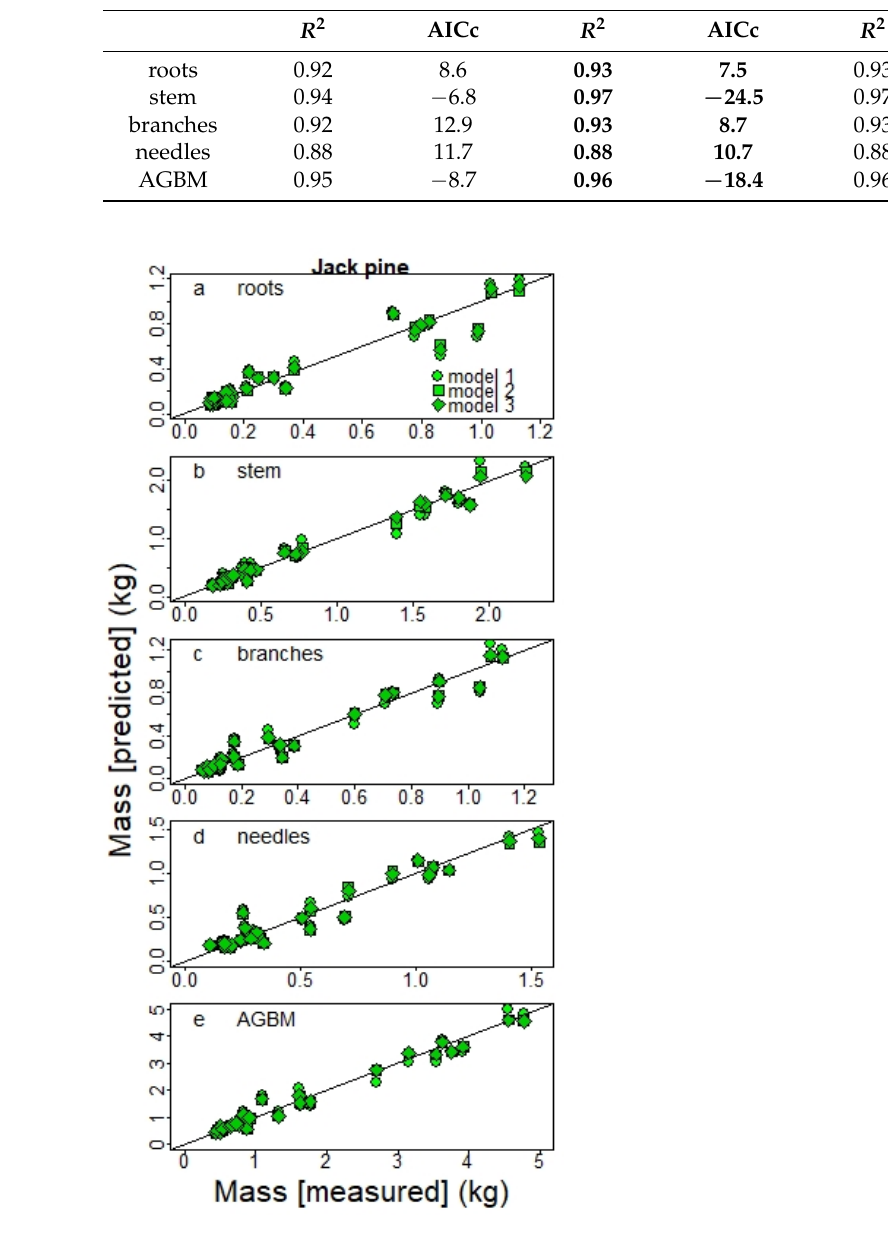
Figure 5. Roots ( a ), stem ( b ), branches ( c ), needles ( d ) and aboveground biomasses ( e ) (AGBM) predicted by the three models vs. measured values for planted Jack pine ( n = 21) trees sampled in boreal open woodlands of Quebec.